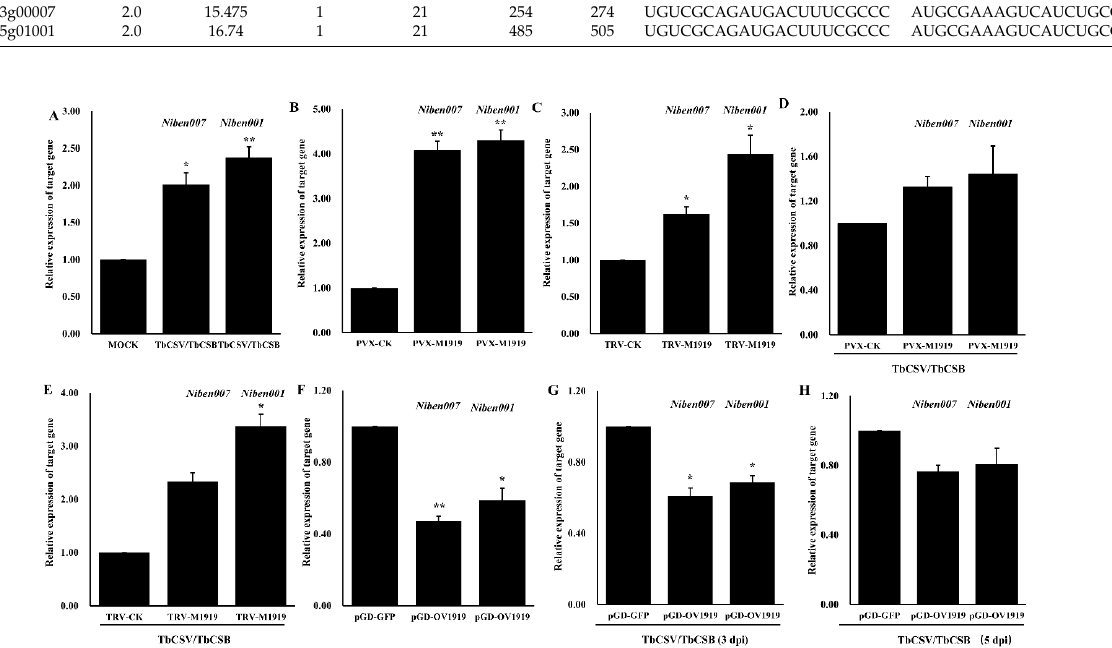
Figure 5. Analyses of the expression of nbe-miR1919c-5p target genes ( Niben001 and Niben007 ) through qRT-PCR. ( A ) At seven days post TbCSV / TbCSB co-inoculation, the assayed plants were sampled and analyzed for the expression of Niben001 and Niben007 through qRT-PCR. N. benthamiana plants inoculated with Agrobacterium cells without virus infectious clones (Mock) were used as controls. ( B ) Detection of Niben001 and Niben007 expression in the PVX-inoculated or the PVX-M1919-inoculated plants through qRT-PCR. ( C ) Detection of Niben001 and Niben007 expressions in the TRV-inoculated or the TRV-M1919-inoculated plants through